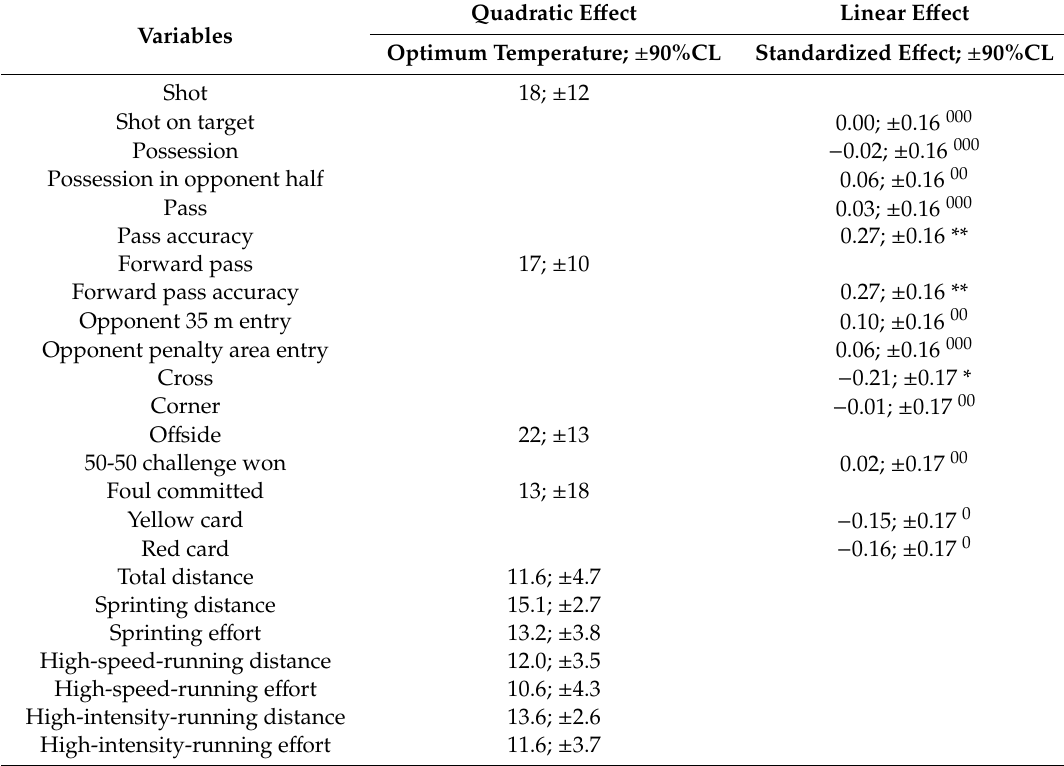
Table 3. E ff ects of temperature on The technical and physical performance of CSL